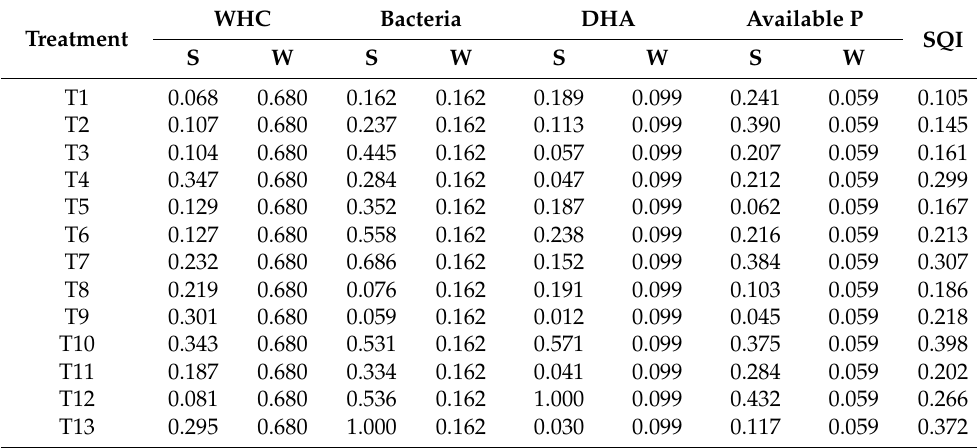
Table 4. Score (S), weight (W) and soil quality index (SQI) values of selected minimum data set (MDS) variables for each